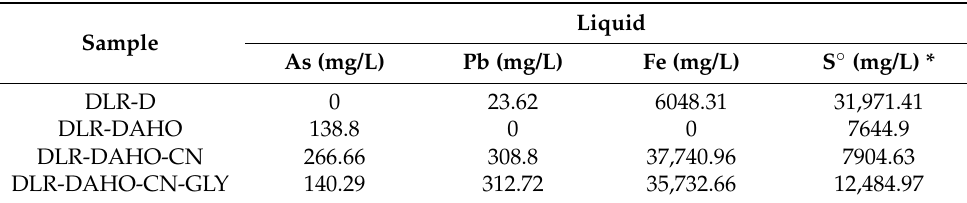
Table 7. Concentration of As, Pb, Fe and S of the liquid samples obtained during the DLR-DAHO pretreatment and the conventional and glycine-assisted